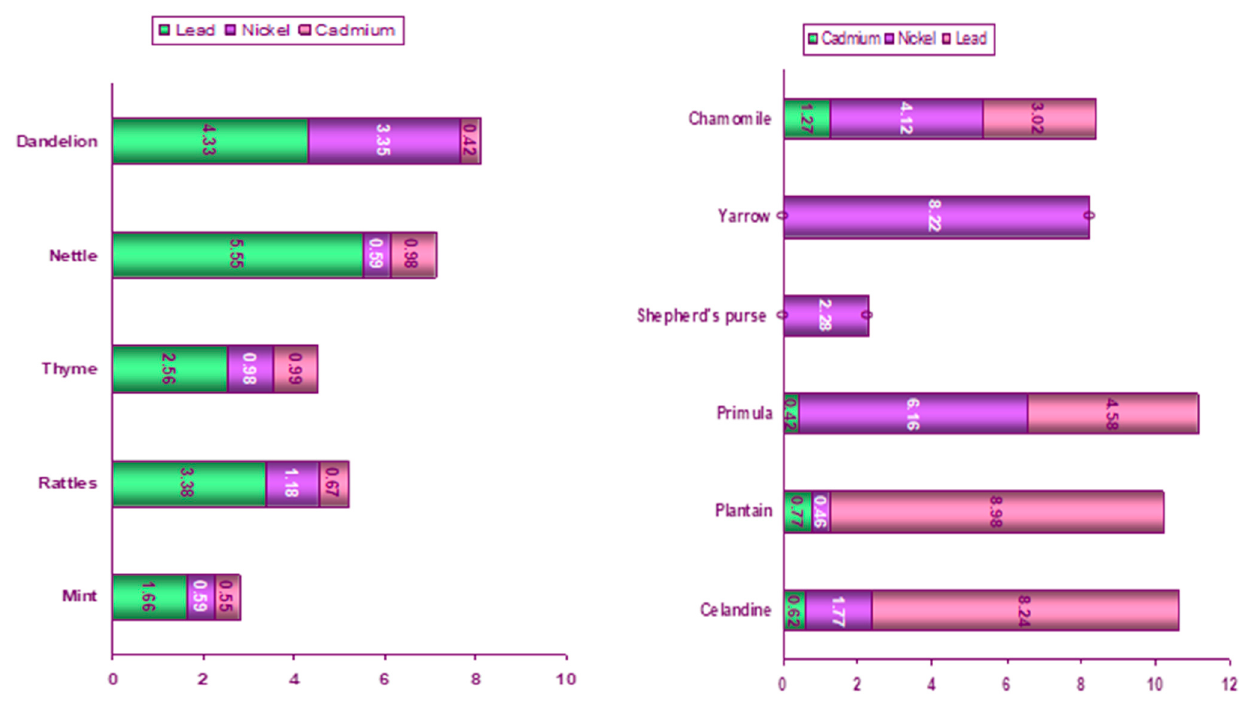
Figure 7. The content of heavy metals in aqueous extract of analysed herbs